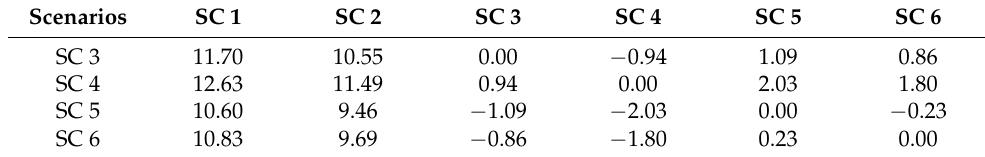
Table 5. Charging cost reduction